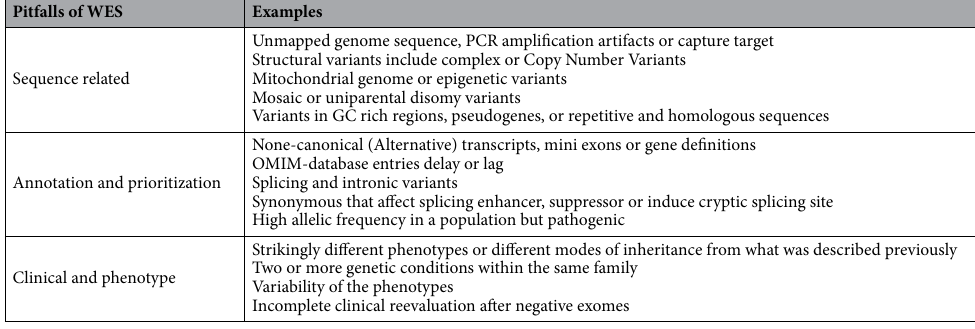
Table 2. Pitfalls and challenges of exome